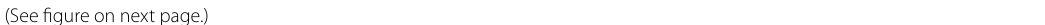
figure on next Fig. 4 Association network of T. gratilla elatensis GMA under different variables of diet and gut region. Association network presenting a the general network (regardless of diet or region), and in different examined niches of diets b Gracilaria , c Pellet, or d Ulva ; or gut regions e esophagus, f stomach, or g intestine. Diamonds indicate hub nodes and triangles indicate driver nodes. Nodes are colored following annotation at Phyla level. Edge color indicates type of association as either co‑occurrence (blue) or co‑exclusion (red). h Venn diagrams reveal number of shared or unique associations in networks of different diets or gut regions (n =